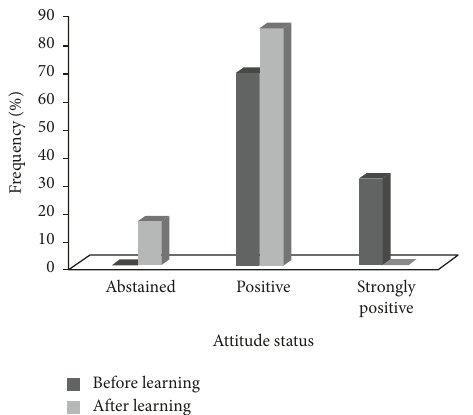
Figure 3: The status of the midwives’ attitude toward electronic continuing medical education before and after the